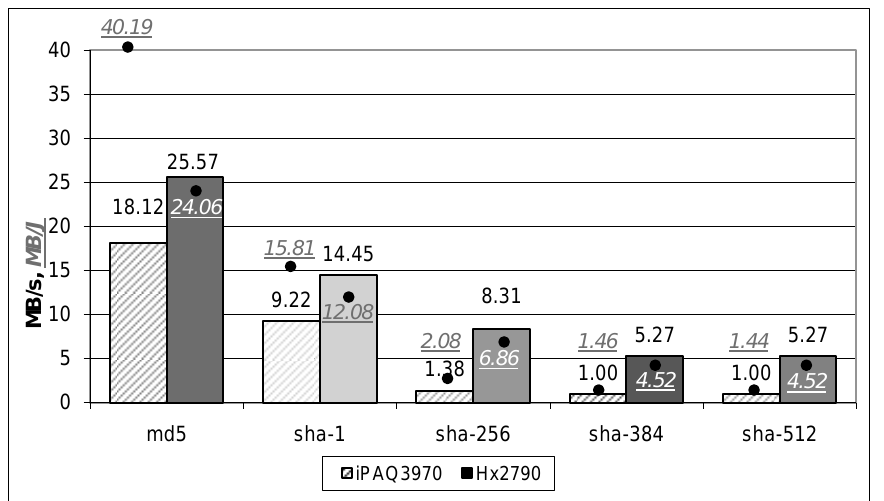
Figure 3. Throughput (represented with bars) and Energy Performance (represented with dots) of hash